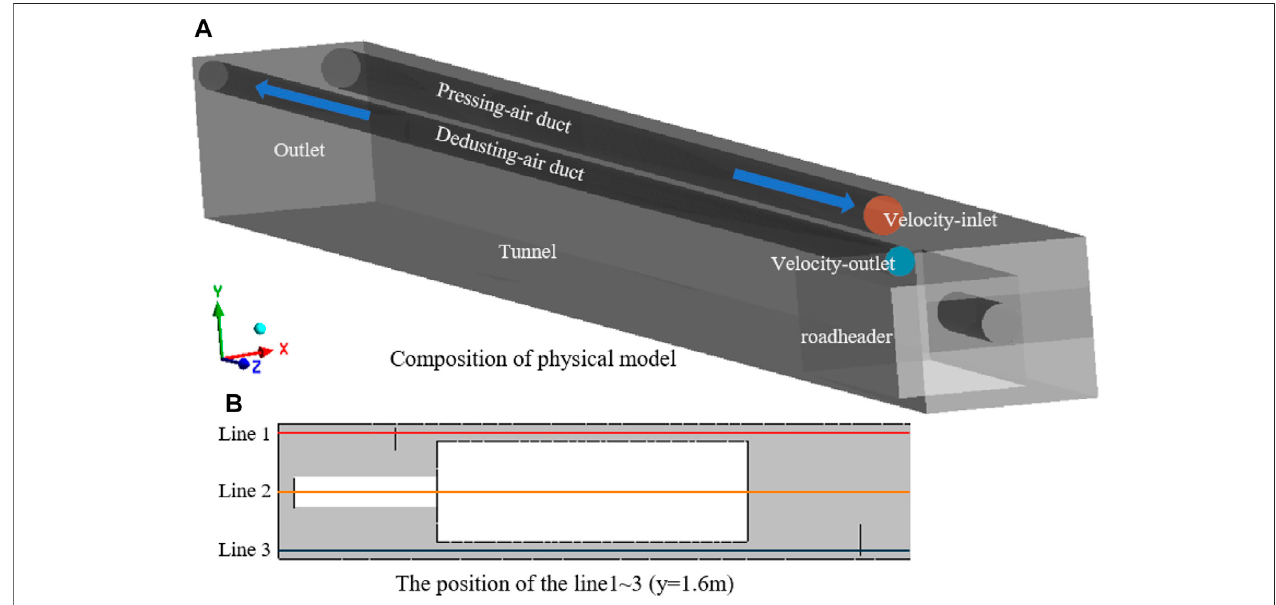
FIGURE 2 | Physical model of Shoushan: (A) Composition of physical model; (B) Position of the line 1~3 (y = 1.6 m).